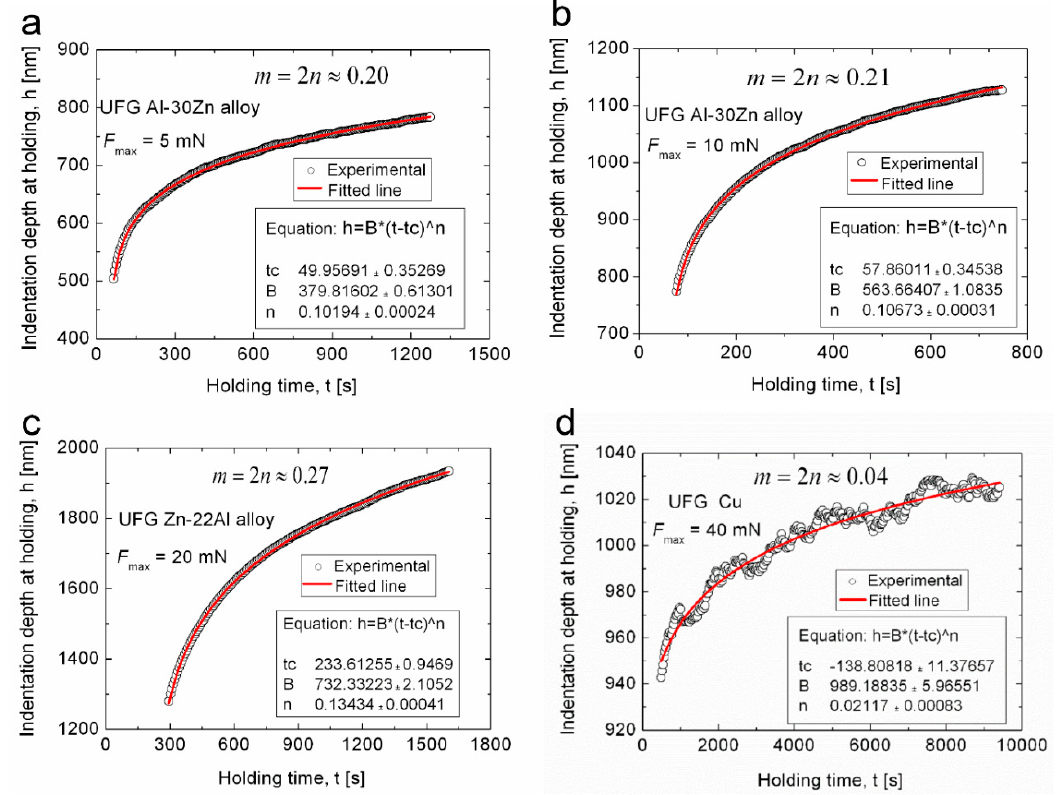
Figure 8. Examples demonstrating the validity of Equation (6) and the determination of the strain rate sensitivity, m. Equation (6) has been fitted to the experimental h-t data obtained at the holding stage for ( a , b ) UFG Al-30Zn, ( c ) UFG Zn-22Al and ( d ) UFG Cu. Reproduced with permission from [58]. Copyright 2019, Elsevier.